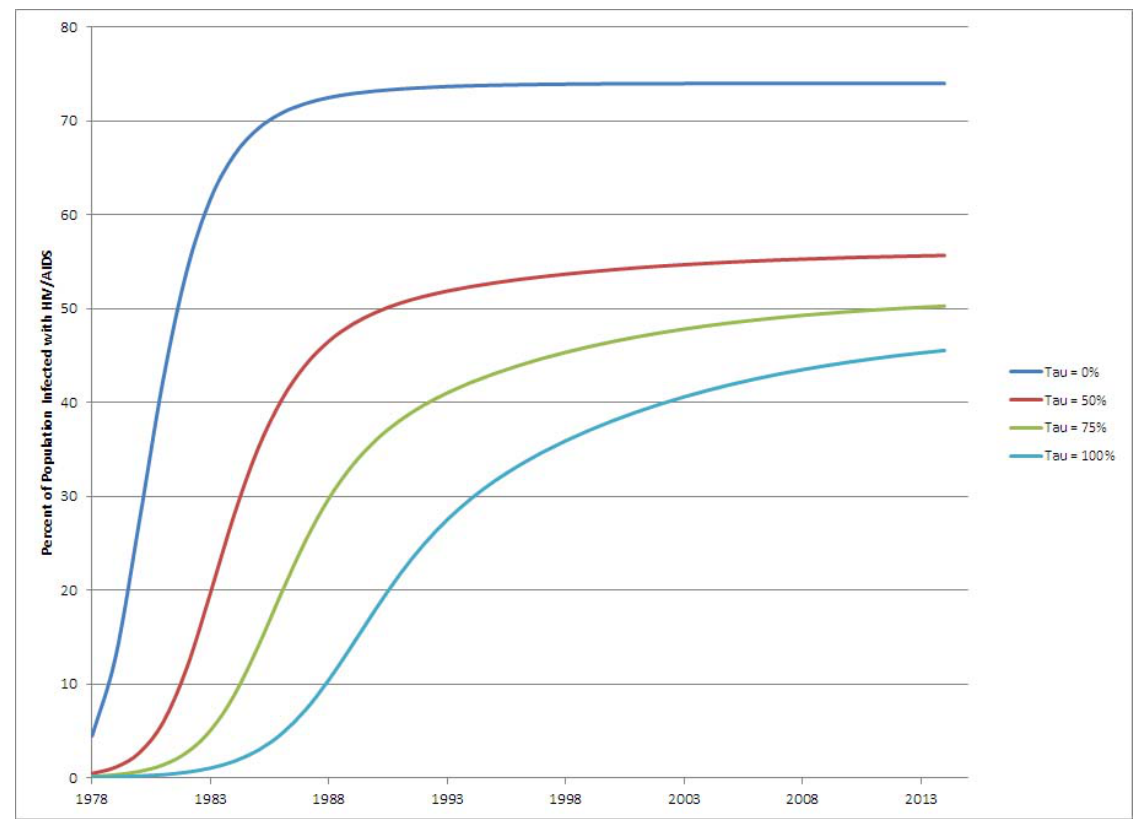
Figure 2. SFCCC epidemic with varying testing rate,